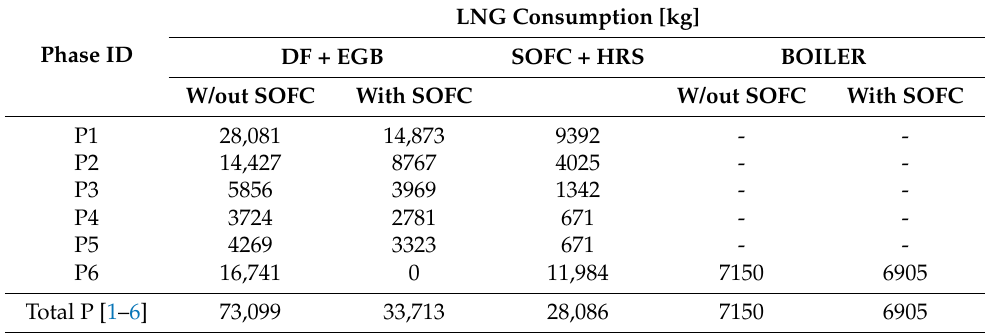
Table 9. Comparison of daily LNG consumption for two different exhaust heat recovery configura- tions (DF + EGB and SOFC + HRS) and